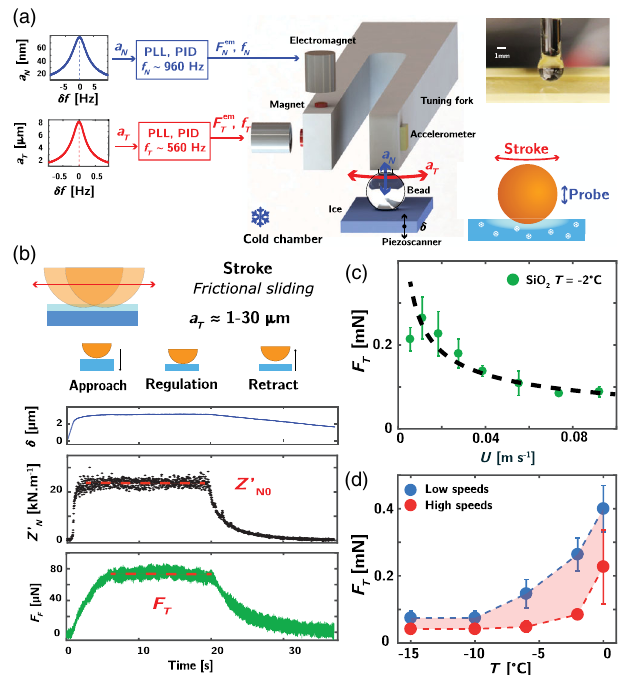
FIG. 1. Stroke-probe tribology of ice. (a) Schematic of the setup. A glass bead of radius R ≈ 1 . 5 mm is glued to a macroscopic tuning fork (not to scale). The tuning fork is excited at its resonances, leading to a tangential and normal bead oscillation in order to simultaneously shear the ice (stroke, horizontal red arrow) and measure the interfacial properties (probe, vertical blue arrow). (b) Typical approach-retract curve for the indentation distance δ , the normal conservative impedance Z 0 N and the tangential frictional force F F at U ¼ 0 . 005 m s − 1 and T ¼ − 6 °C. Maintaining the contact to a prescribed normal impedance value Z 0 N 0 allows us to define a steady-state friction force F T . (c) Steady-state friction force F T as a function of tangential speed U . The dashed line is a fit according to F ∝ U − γ , with γ ¼ 0 . 5 . T (d) Friction force F T as a function of the ice temperature for two distinct velocities ( U ¼ 0 . 01 m s − 1 and U ¼ 0 . 1 m s − 1 ), exhibit- ing a steady increase close to the melting